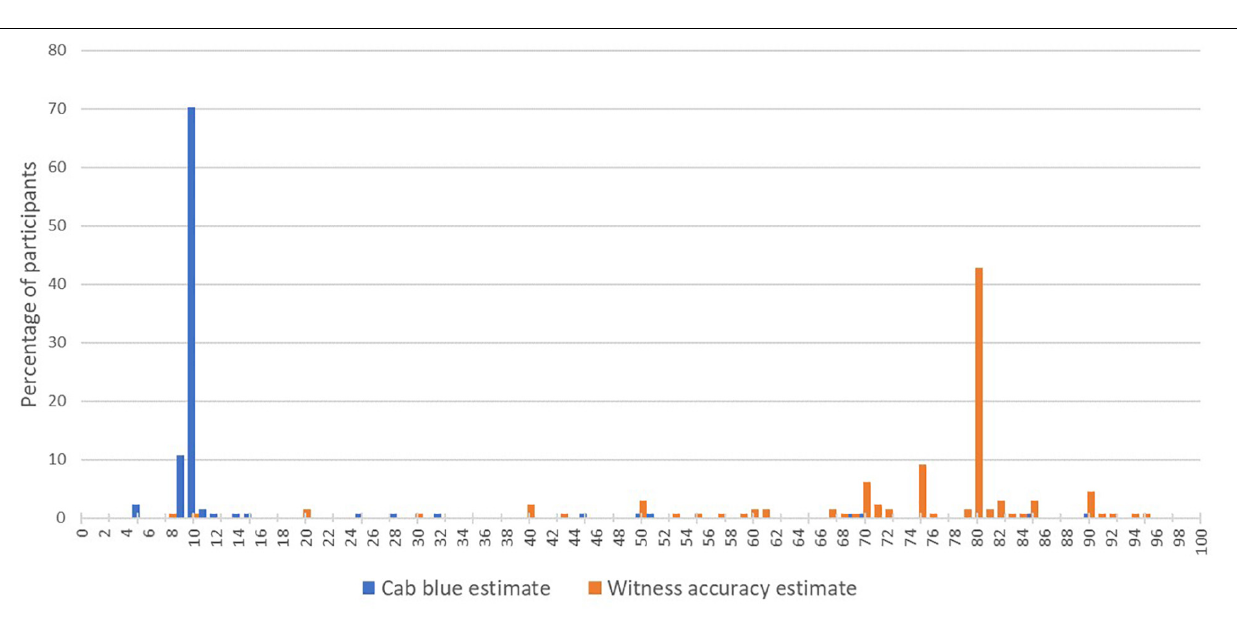
[ F (2,128) = 2.6, p = 0.08]. Pairwise comparisons compared